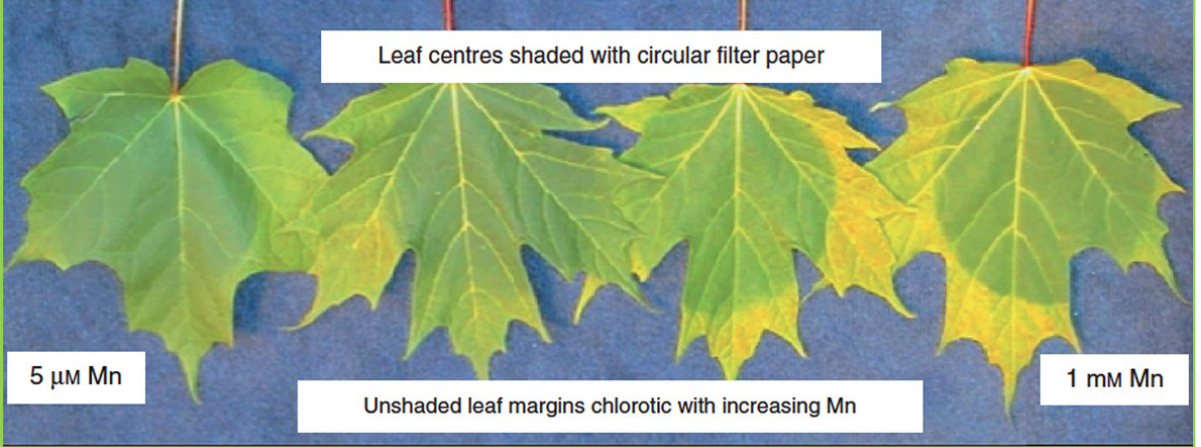
Figure 3. Mn toxicity-induced photobleaching of Mn-treated maple leaves exposed to sunlight [60].